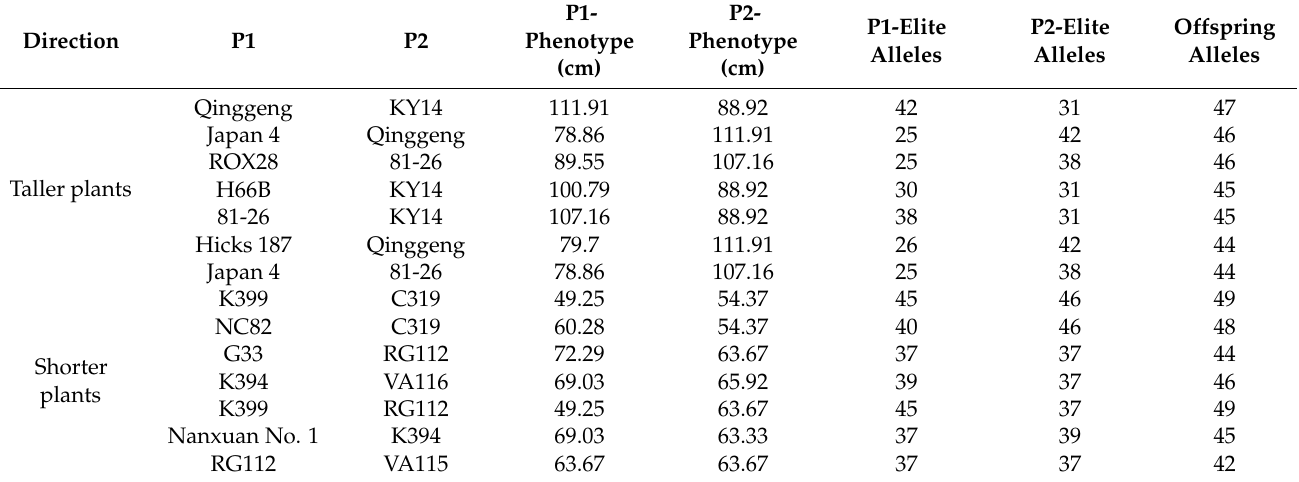
Table 3. Best parental cross combinations in two directions for plant height in tobacco from elite alleles.